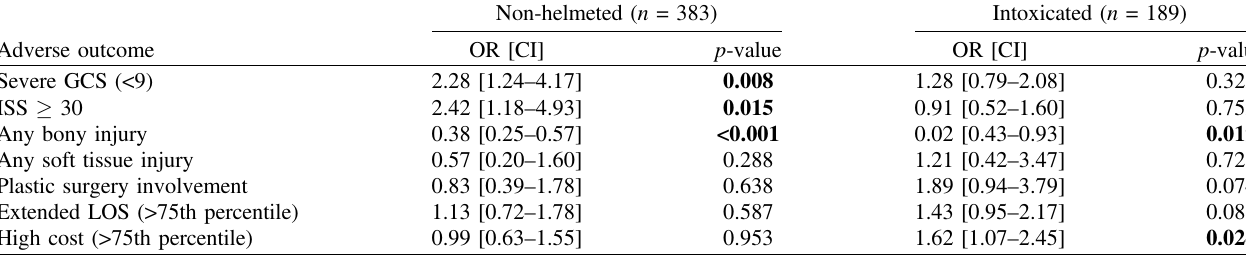
Table 4. Impact of helmet and intoxication status on selected adverse